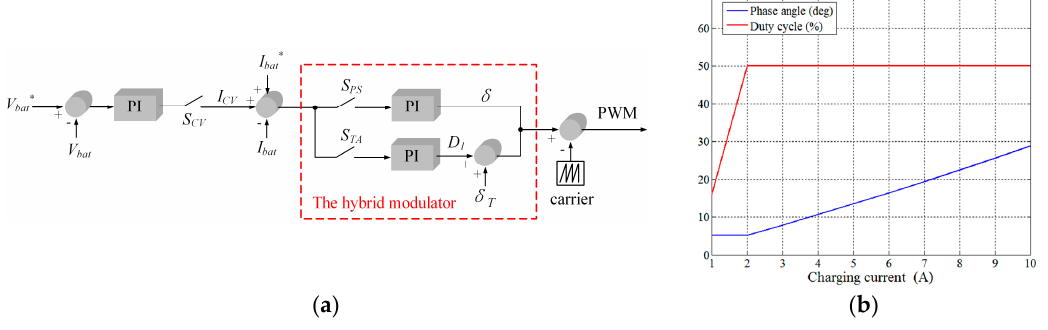
Figure 6. The control scheme and hybrid modulation. ( a ) The control scheme of the converter; ( b ) Phase angle and duty cycle of hybrid modulation.